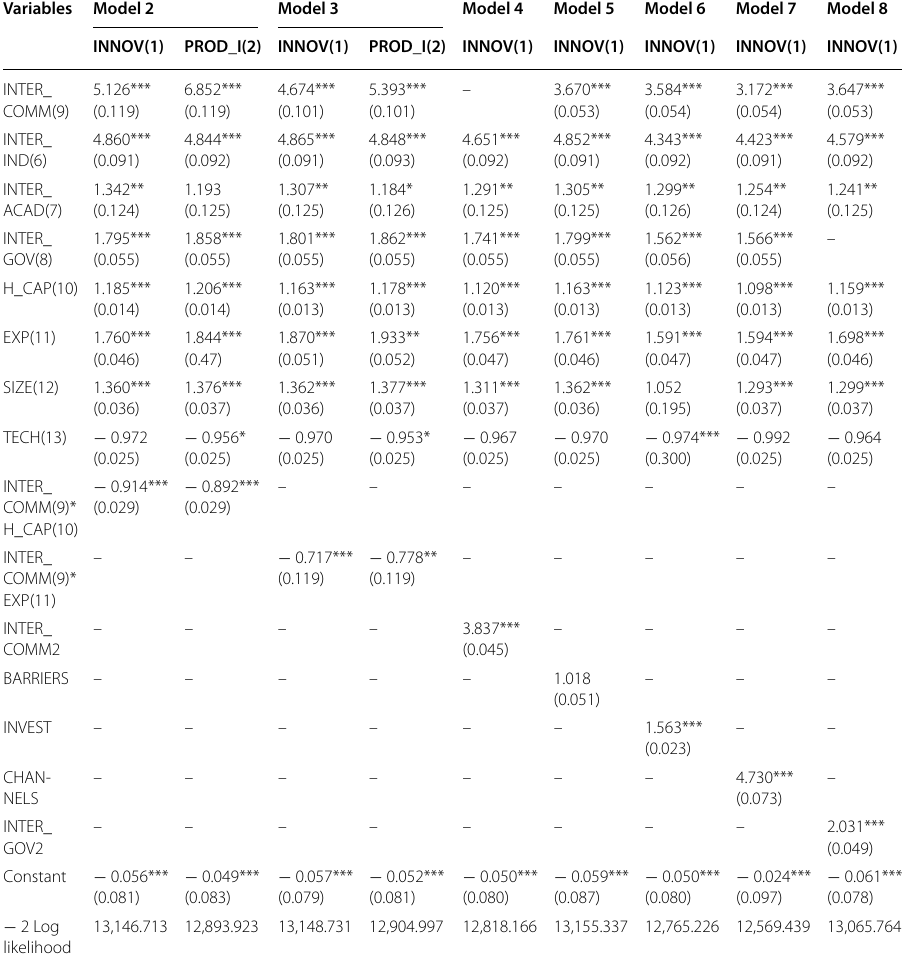
Table 11 Robustness check